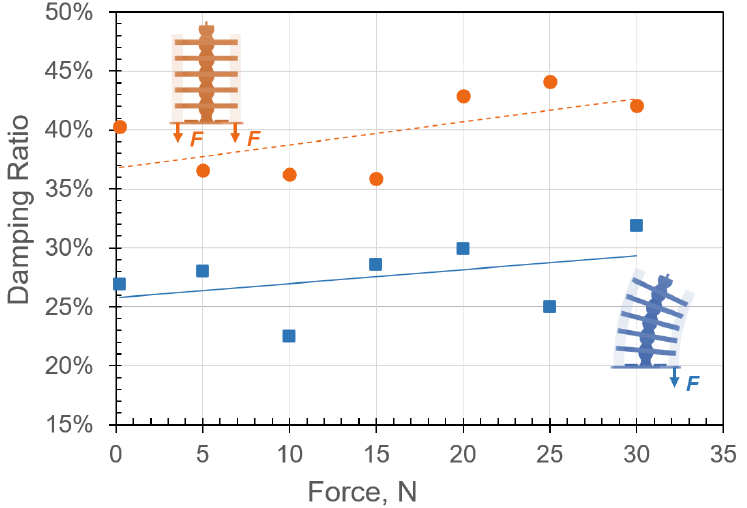
Figure 19. Damped undulation due to energy dissipation for single- and double-sided tension configurations in blue and orange, respectively. The damping ratio appears to increase linearly as the internal force is increased for both